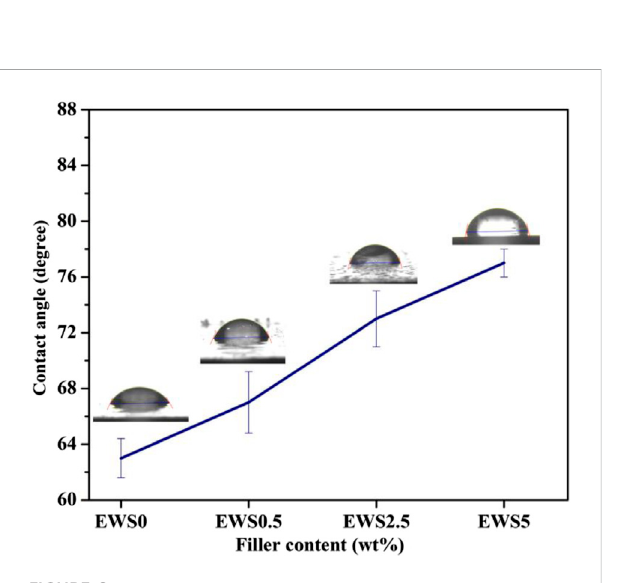
FIGURE 6 Water contact angle values of wool-epoxy-nanosilica composites.